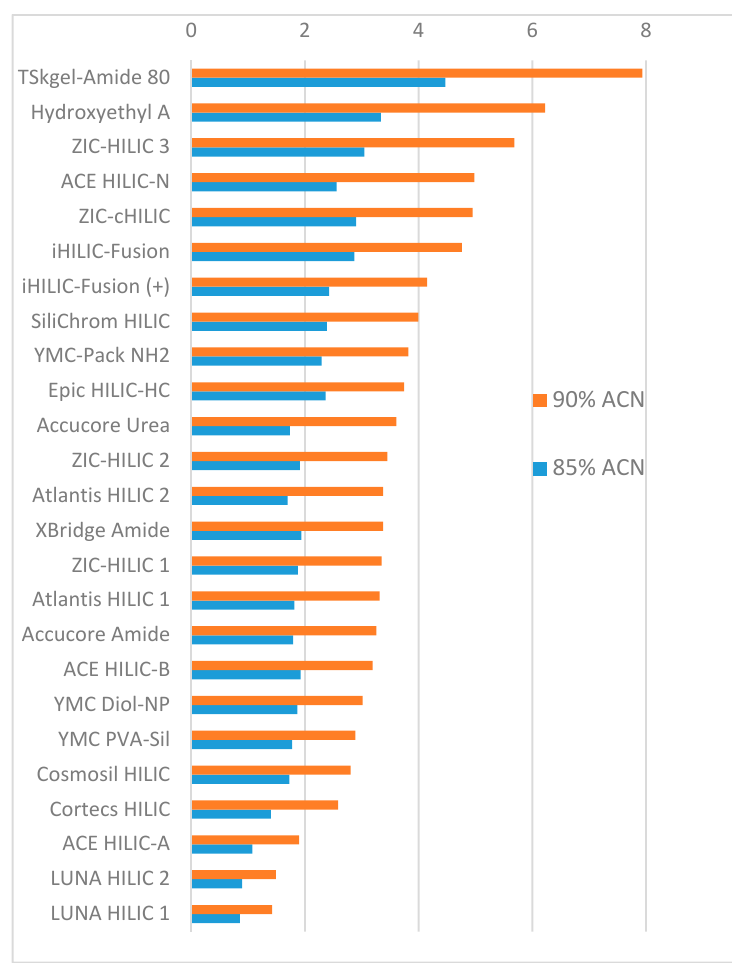
Figure 3. Cytosine retention factors on three polar stationary phases measured in the mobile phase containing 85% acetonitrile and ammonium acetate concentration 4–30 mM.